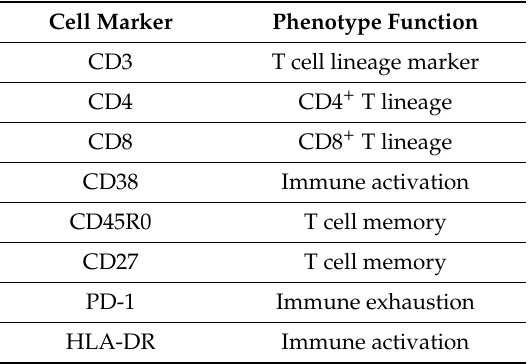
Table 1. Cell surface markers used as parameters to define T cell